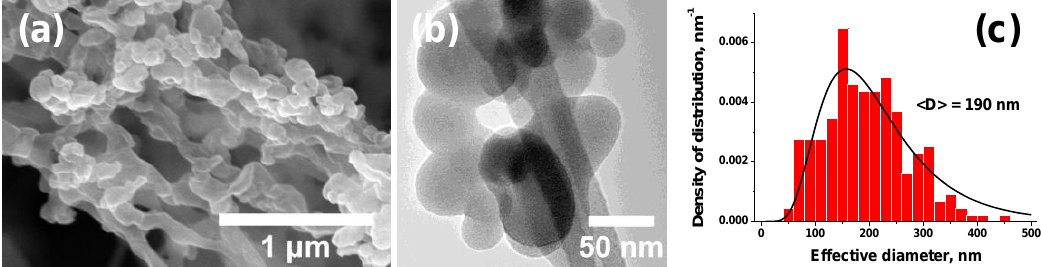
Figure 2. Morphology of NC (sc) : scanning ( a ), transmission ( b ) electron microscopy, and numerical particle size distribution ( c ). Note that image (b) shows the nanoparticles localized on transmission electron microscope (TEM) grid.